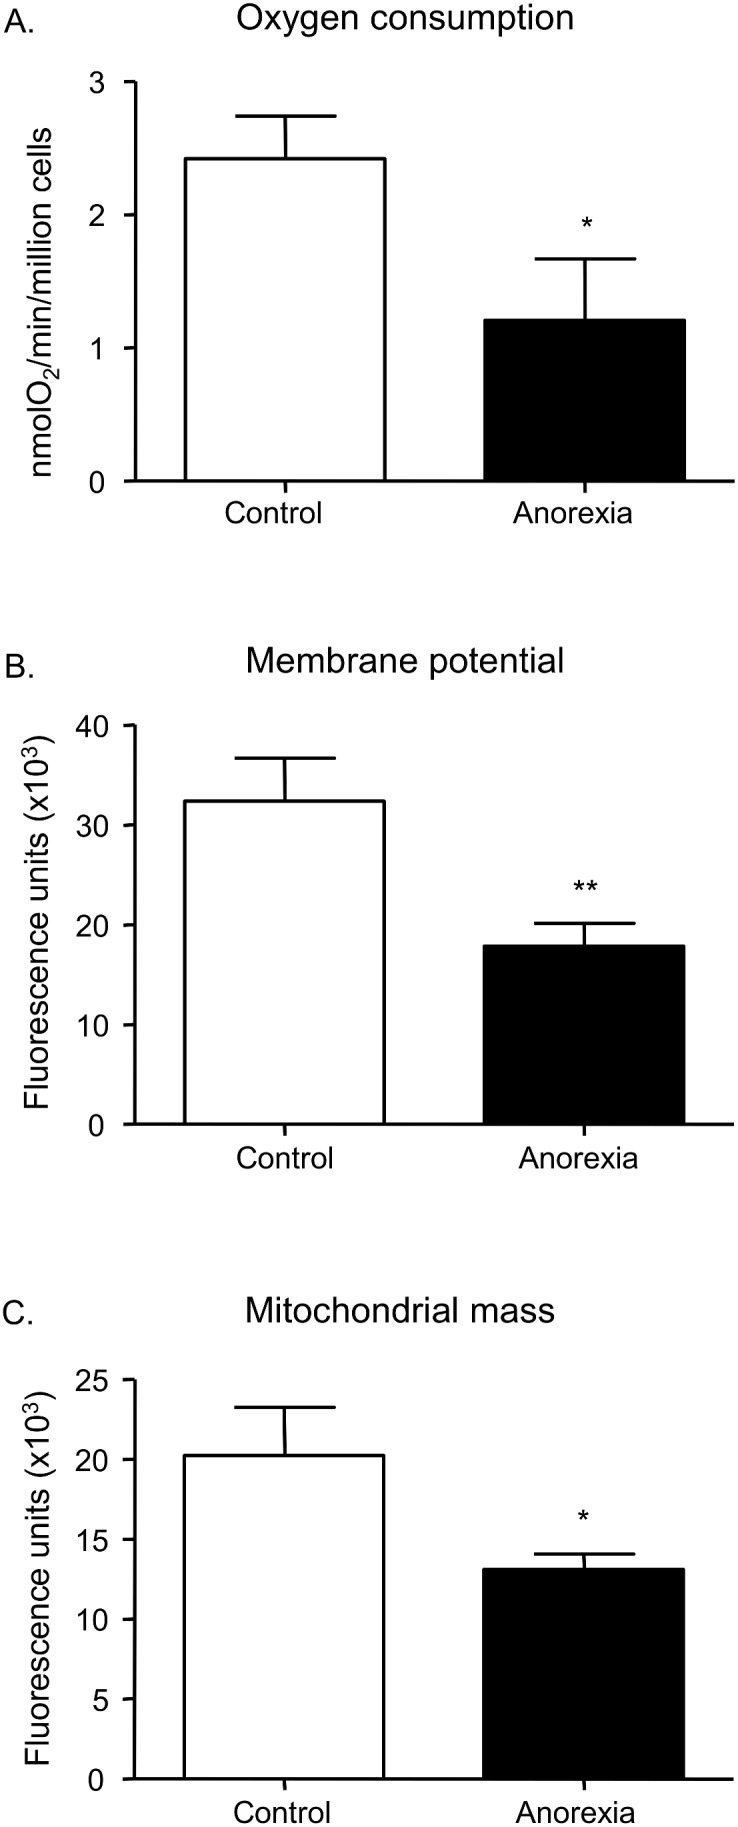
Effect of anorexia on O2 consumption (A) rate, measured as nmol O2/min/million cells, on membrane potential (B), measured by TMRM fluorescence, and on mitochondrial mass (C), measured by NAO fluorescence. n = 20 per group.*P<0.05 and **P<0.01 vs. control.